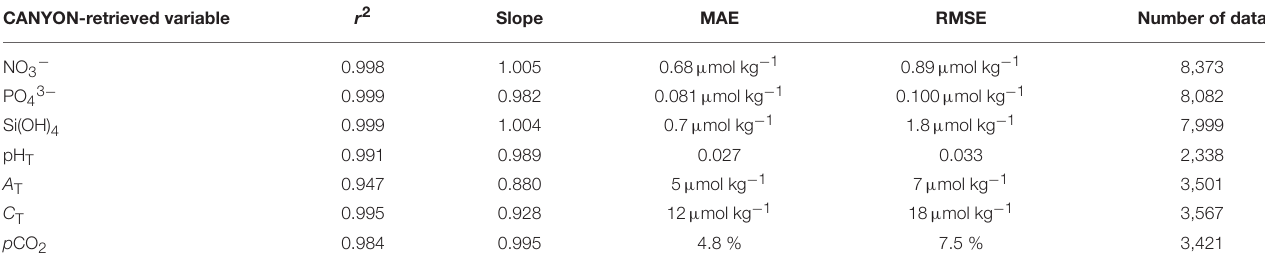
TABLE 4 | Comparison statistics between the values retrieved by CANYON vs. the corresponding measurements in the HOT database. CANYON-retrieved variable r